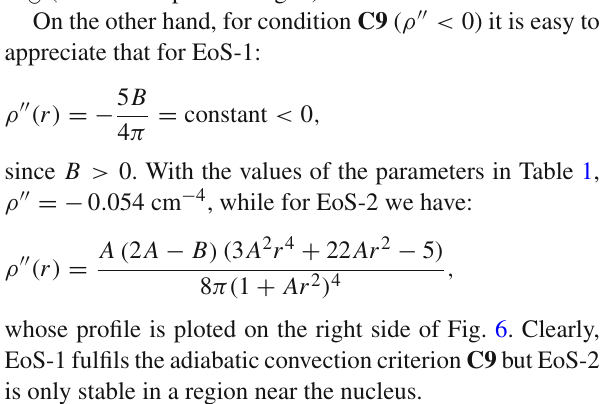
Fig. 5 Velocity of sound vs the dimensionless radius ξ = r / r b for a matter configuration with master anisotropic polytropic: EoS-1 (left) andEoS-2(right).Theupperplatesshowtheradialspeedofsoundwhile the lower ones the tangential for different values of n having σ = 0 . 12. that M is a linear function of the central density ρ c , while